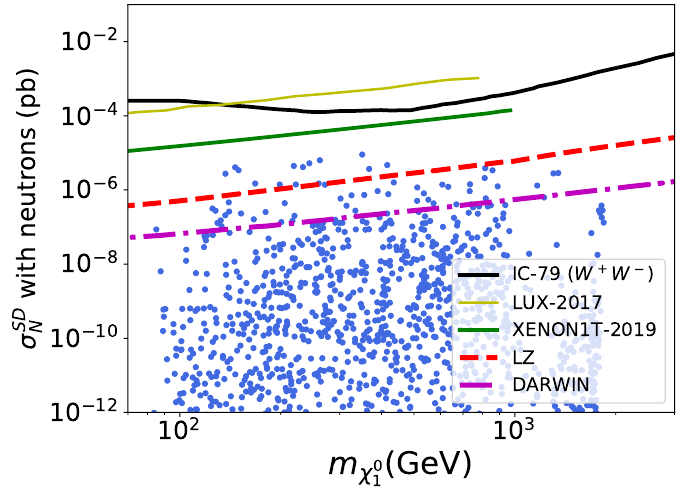
Figure 11 . SD cross-section with its current limits and future